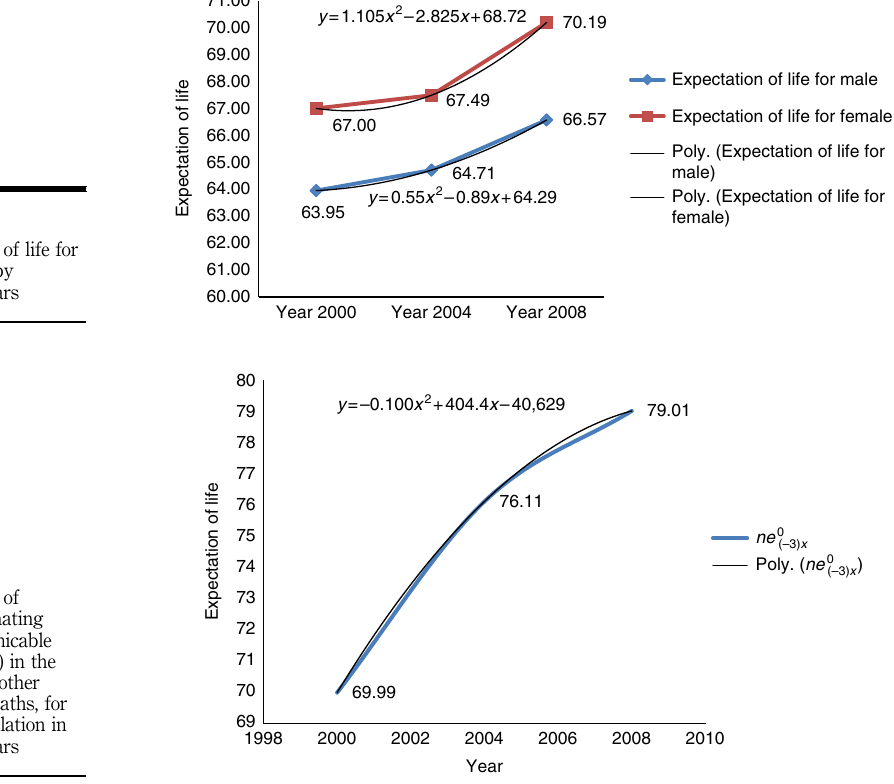
Figure 3. Expectation of life for both sexes by different years